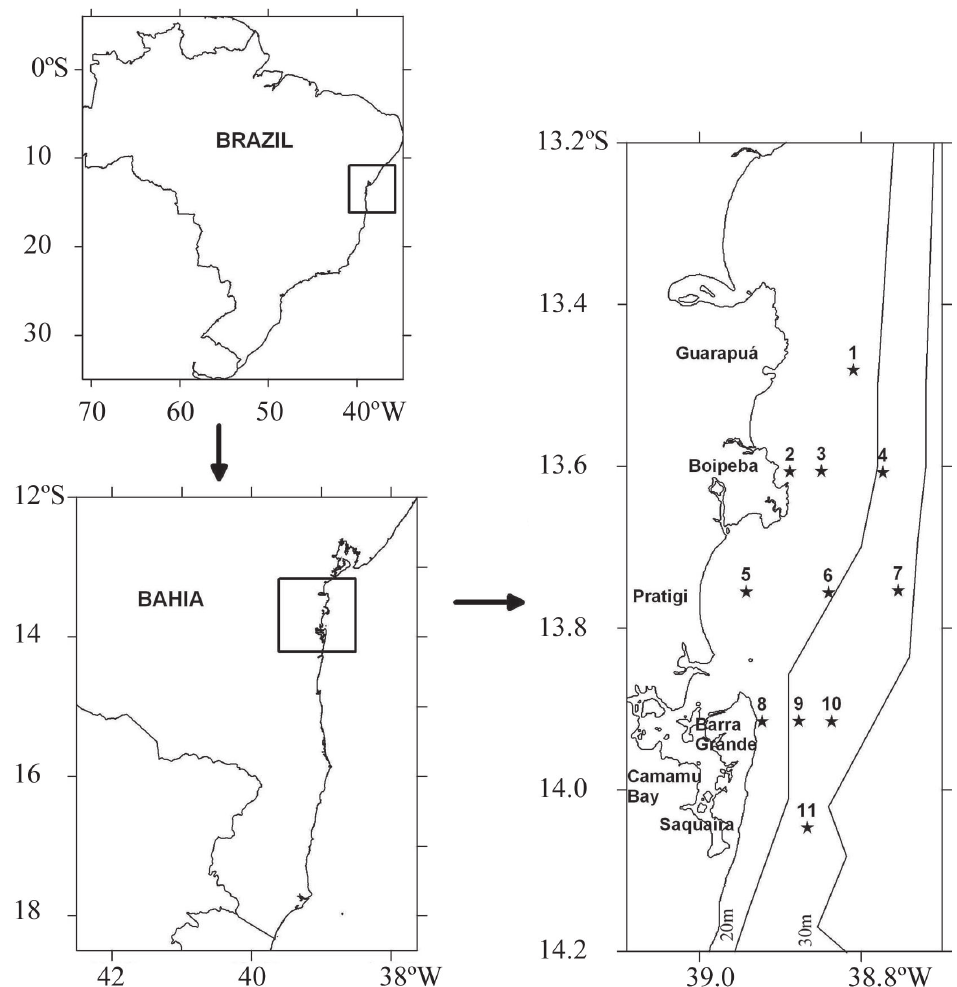
Figure 1. Sampling locations on the inner shelf adjacent to the coastal system of Camamu